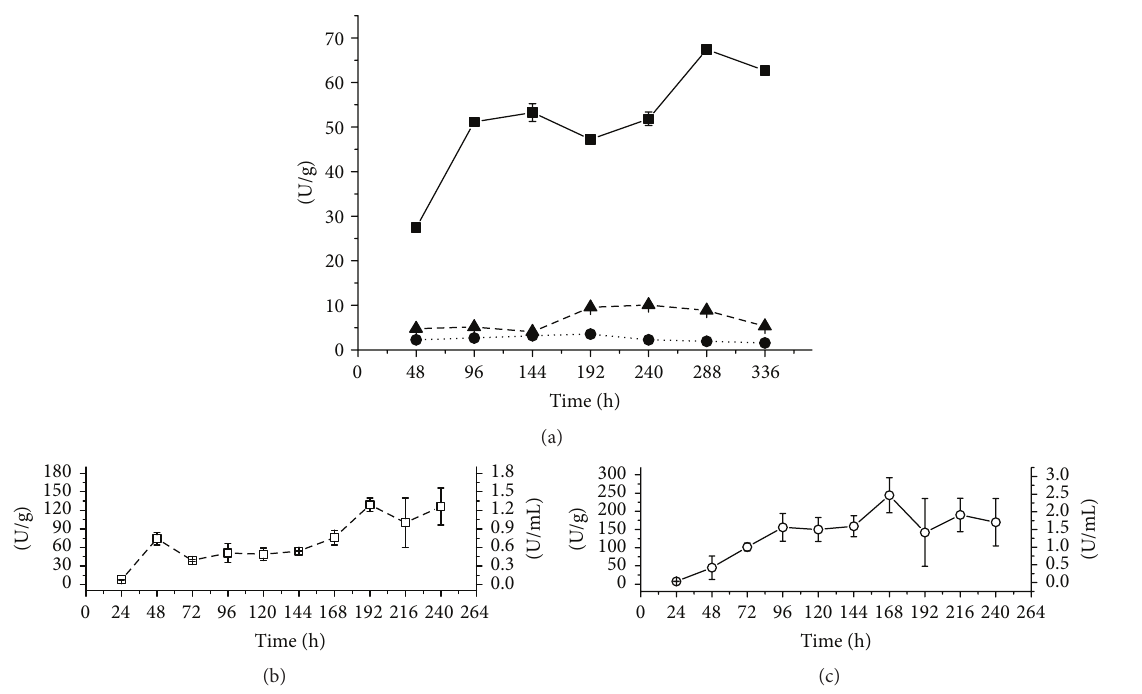
Figure 2: (a) 𝛽 -Glucosidase production (expressed as U/g) by M . heterothallica F.2.1.4. in solid-state cultivation. ( ◼ ) SSCWB; ( e ) SSCP; ( 󳵳 ) SSCLB. 𝛽 -Glucosidase production in submerged cultivation expressed as U/g and U/mL. (b) ( ◻ ) SmCWB; (c) ( I )